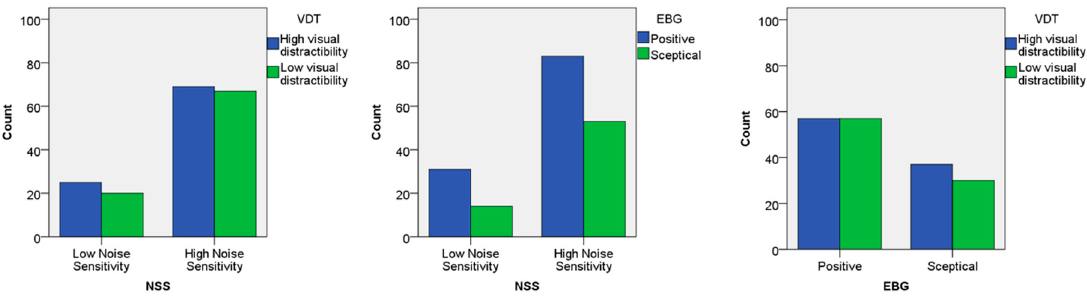
Figure 11. Bar charts representing the number of participants, sorted according to the groups of the three person-related variables (NSS*VDT, NSS*EBG, and EBG*VDT).